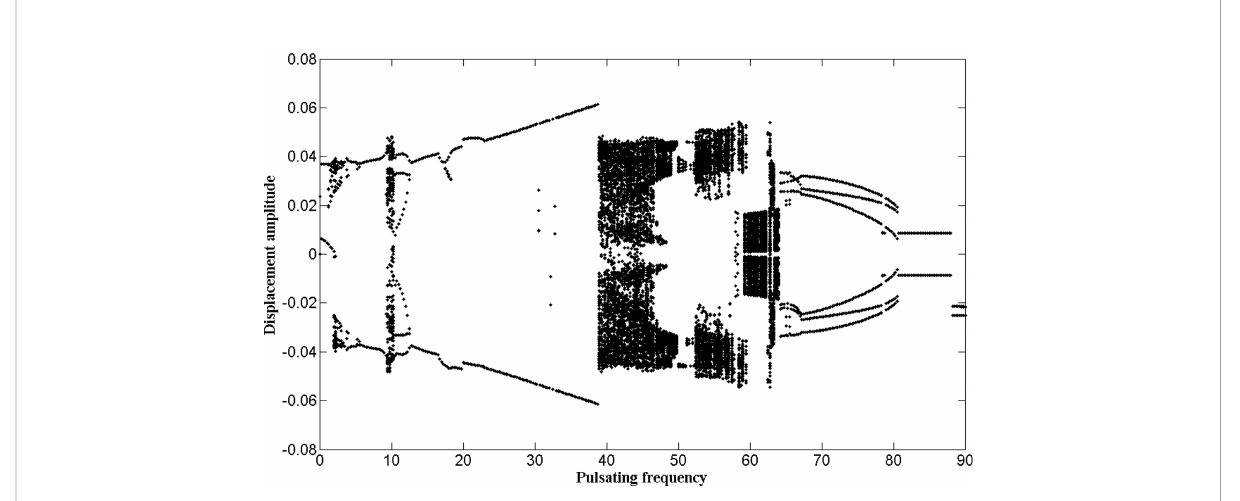
FIGURE 19 The bifurcation diagram for the midpoint of the pipe when the internal fl uid velocity is higher than the divergent critical velocity (in which m = 0.6, u = 4.5, υ = 2, and the control parameter is the pulsating frequency w p